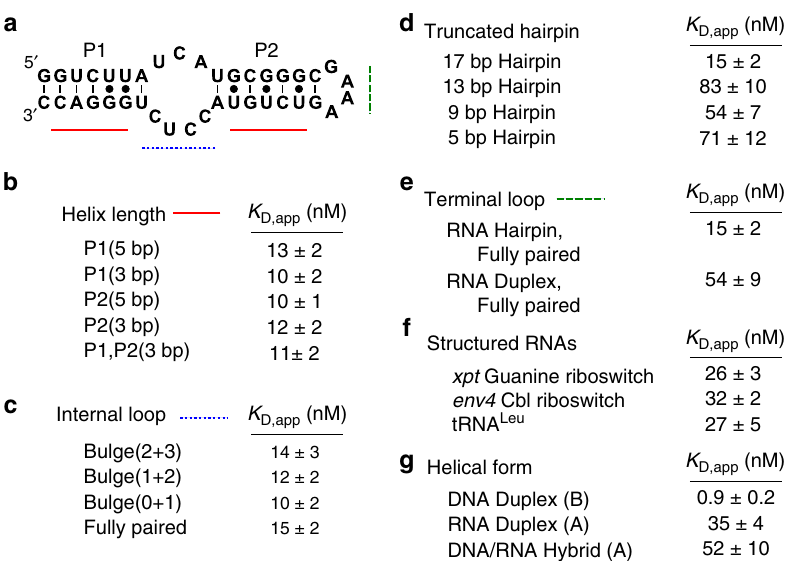
Fig. 3 Interrogation of RNA features for high-af fi nity interaction with Sox2-HMG. a Secondary structure of the Loop B RNA with the designated paired regions (P1 and P2), internal loop (blue dotted line), and terminal loop (green dashed line). Binding assessed to mutations b reducing paired region helix length, n = 8, c reducing the internal loop size, n = 8, d truncation of hairpins, n = 3 e removing the terminal loop, n = 6, f structured RNAs, xpt riboswitch and env4 Cbl riboswitch, n = 4, tRNA Leu , n = 3, and g nucleic acid duplexes with n = 3 technical replicates each. Apparent binding af fi nity displayed as the average with s.e.m. reported.